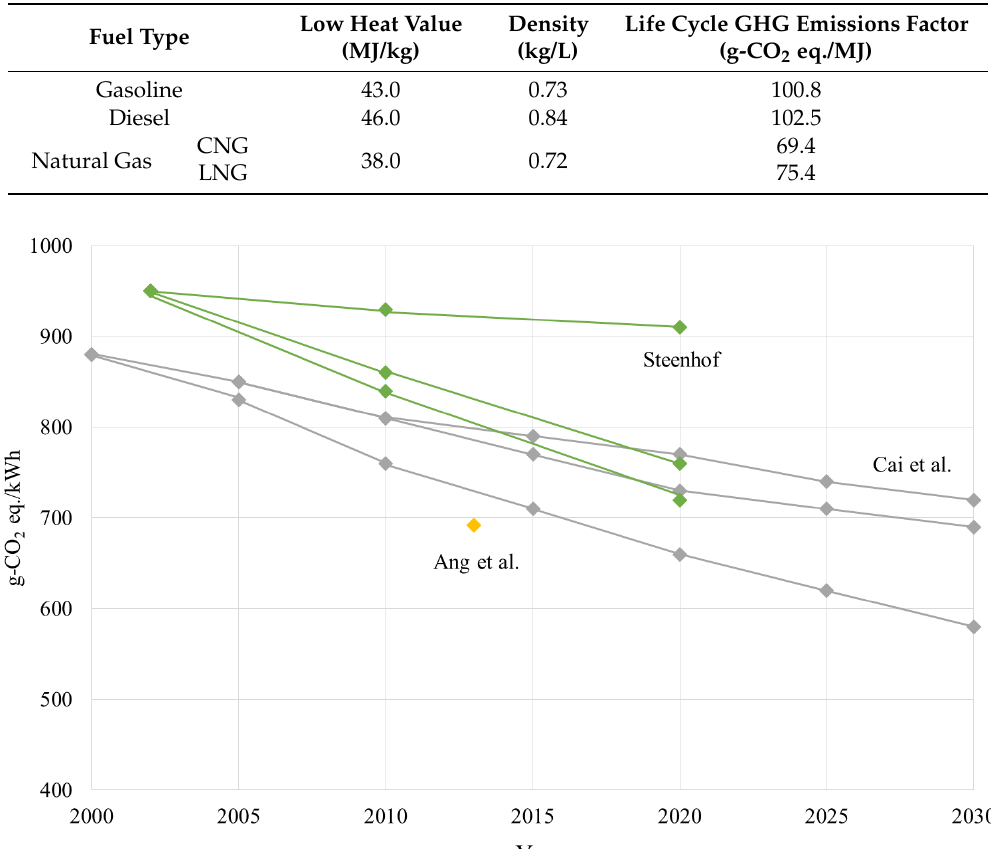
Figure 4. Different researches about electricity GHG emissions intensities.